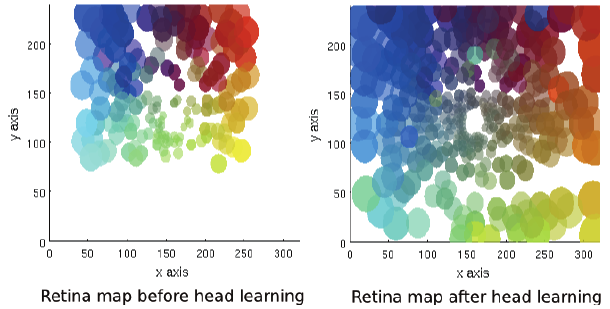
Figure 7. Retina eye map from learning from a single target for 10 minutes with just the eye, then a further 50 minutes with the head moving.